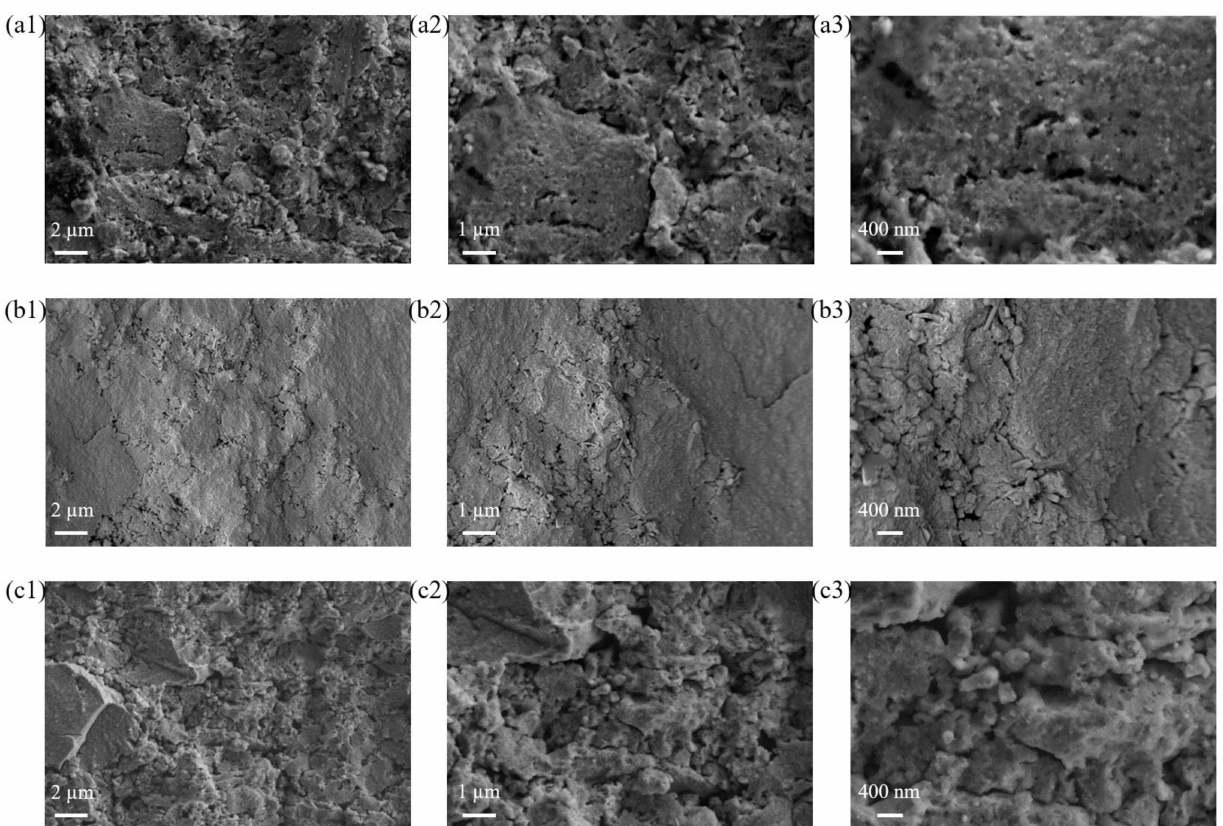
Figure 4. SEM images of the sintered samples: ( a1 – a3 ) d_GZSe-1; ( b1 – b3 ) d_GZSe-2; ( c1 – c3 ) d_GZSe- 3. Magnifications are 5000 × (1), 10,000 × (2), and 20,000 × (3) respectively. The scale bars are 2, 1, and 0.4 µ m, respectively.